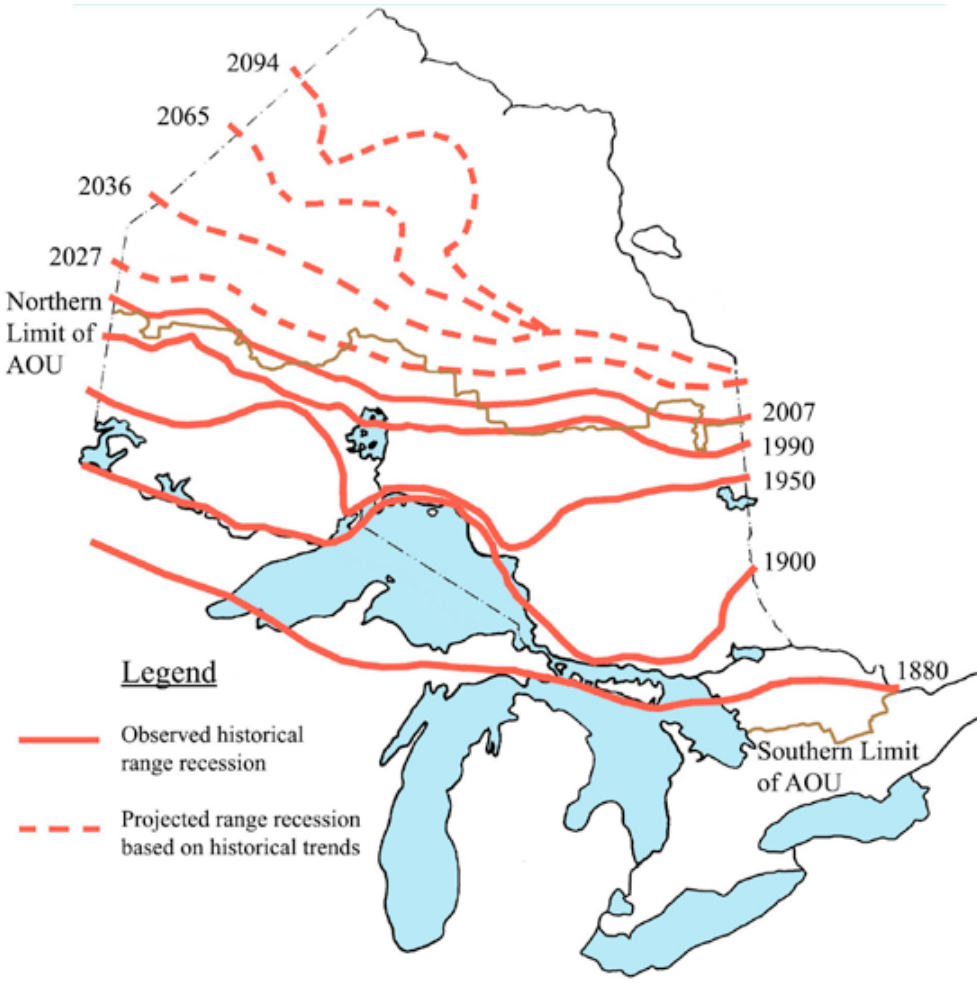
Fig. 1. Map of historical and projected range recession of forest-dwelling woodland caribou ( Rangifer tarandus caribou ) in Ontario, Canada (adapted from Cumming & Beange, 1993; Perara & Baldwin, 2000; Schafer, 2003). This map reflects Schaefer’s (2003) analysis of data from the Ministry of Natural Resources, historical data, and other sources. Schaefer (2003) posits that Ontario’s forest-dwelling caribou population will be extirpated from the province by the year 2094. The 2094 line on the map reflects the northern limit of the tree line. The “AOU” lines represent the area where commercial timber harvesting currently is